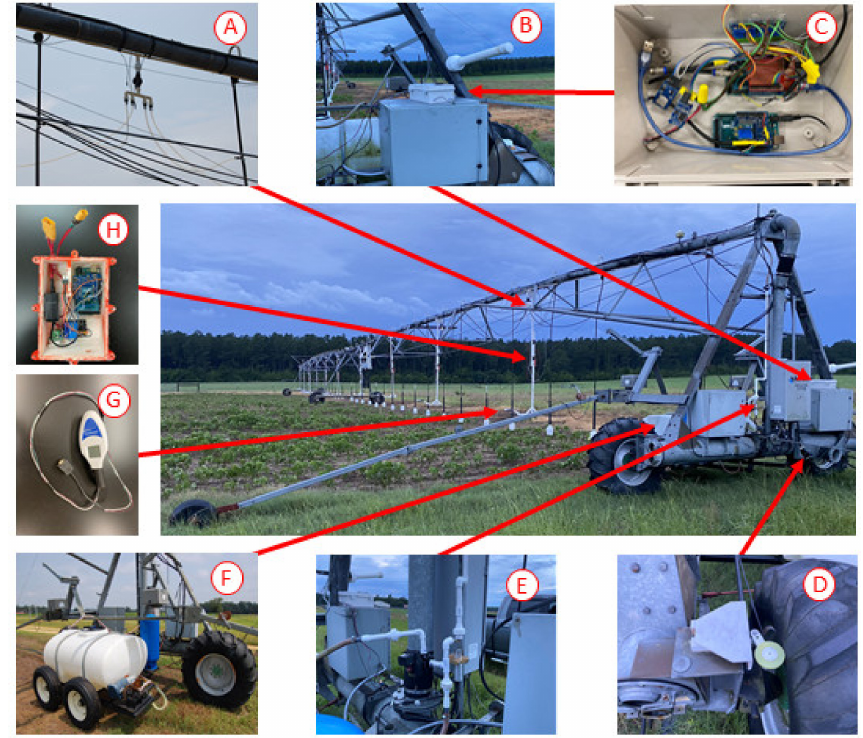
Figure 3. The systems’ major components: ( A ) the N injection point, ( B ) the mainline controller, ( C ) the mainline controller interior, ( D ) the rotary encoder mounted against the lateral’s wheel, ( E ) the flow control bypass system, ( F ) the N supply tank, ( G ) the modified handheld GreenSeeker, and ( H ) the field